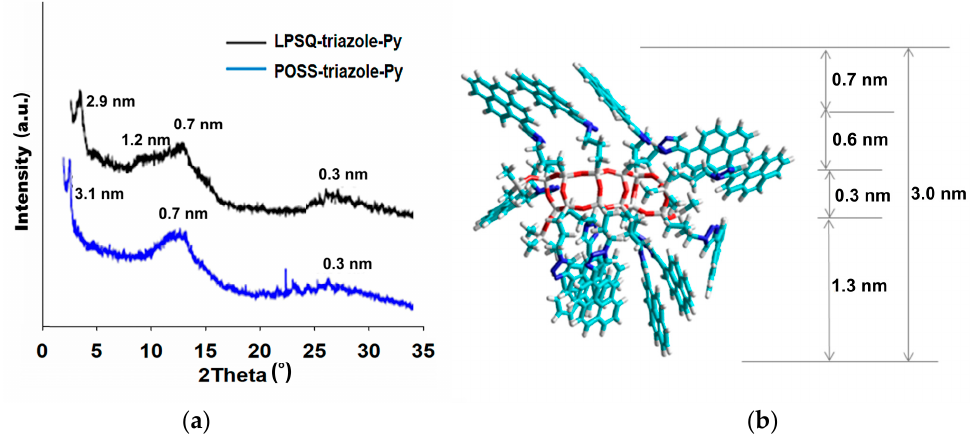
Figure 5. (a ) WAXS diffractograms of thin films of LPSQ and POSS-triazole-Py. ( b ) HyperChem calculated structure for LPSQ-triazole-Py.